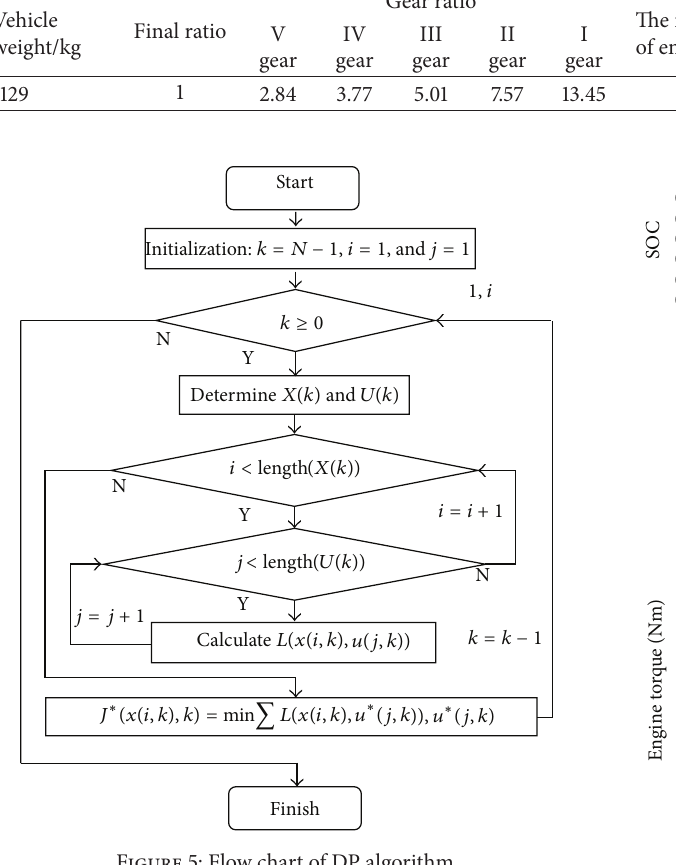
Figure 8: Engine operating points of strategy